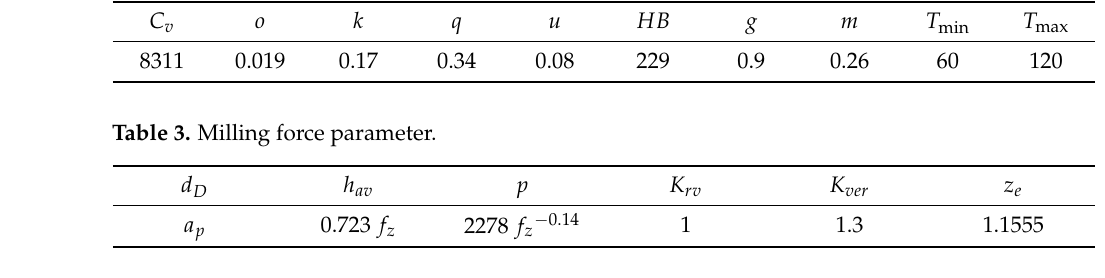
Table 4. The relevant parameters in the objective